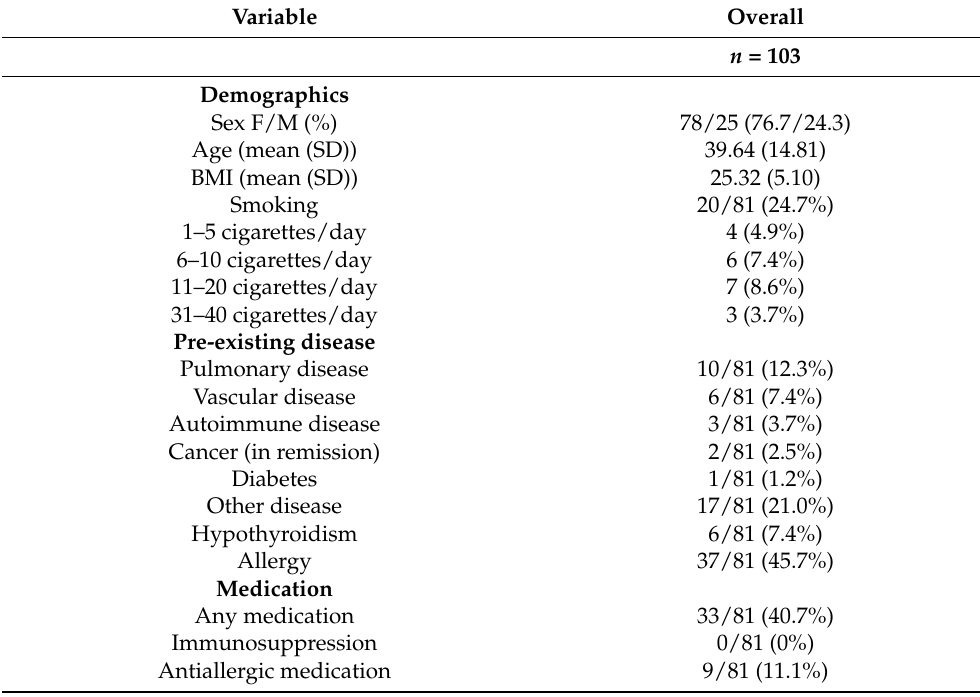
Table 1. Patient demographics and clinical